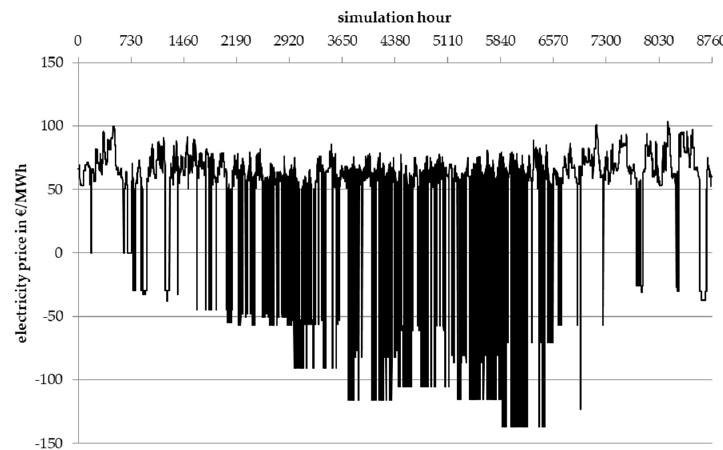
Figure 3. Market prices for one year in the extended scenario.